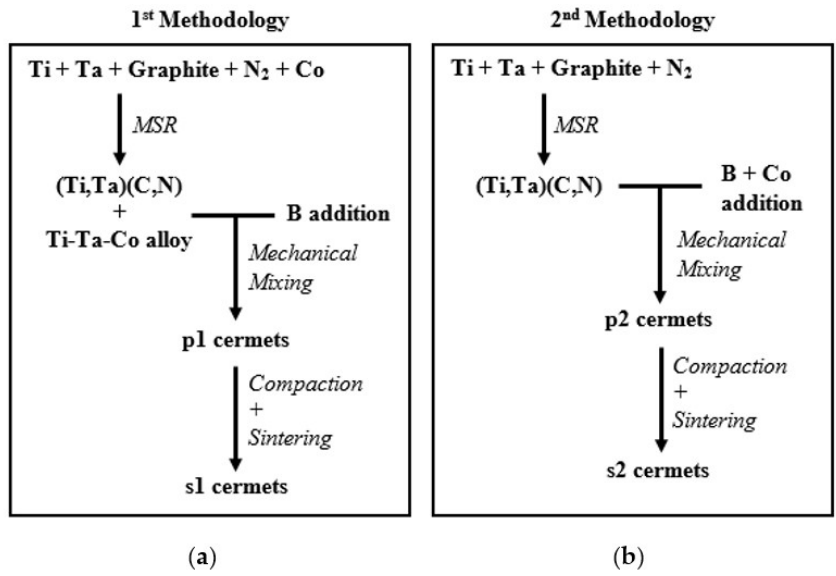
Figure 1. Representative schemes of the two methodologies ( a , b ) used to develop the corresponding sets of (Ti,Ta)(C,N)-Co-B based cermets.